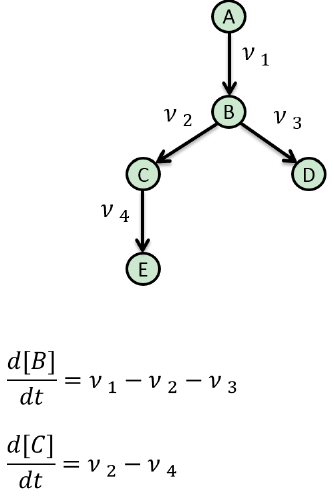
Figure 2. A simple pathway illustrating a metabolic flux